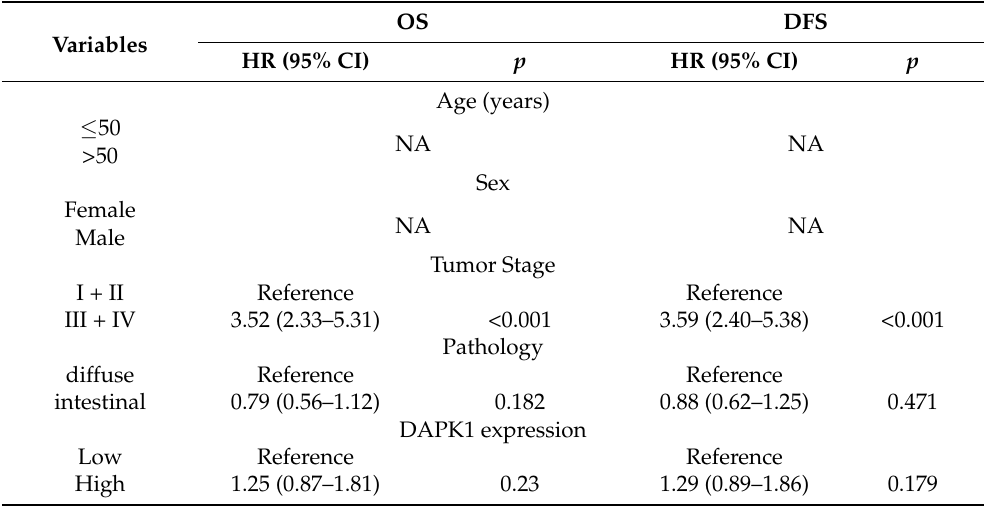
Table 3. A multivariate Cox analysis for OS and DFS of GC patients based on the GSE62254